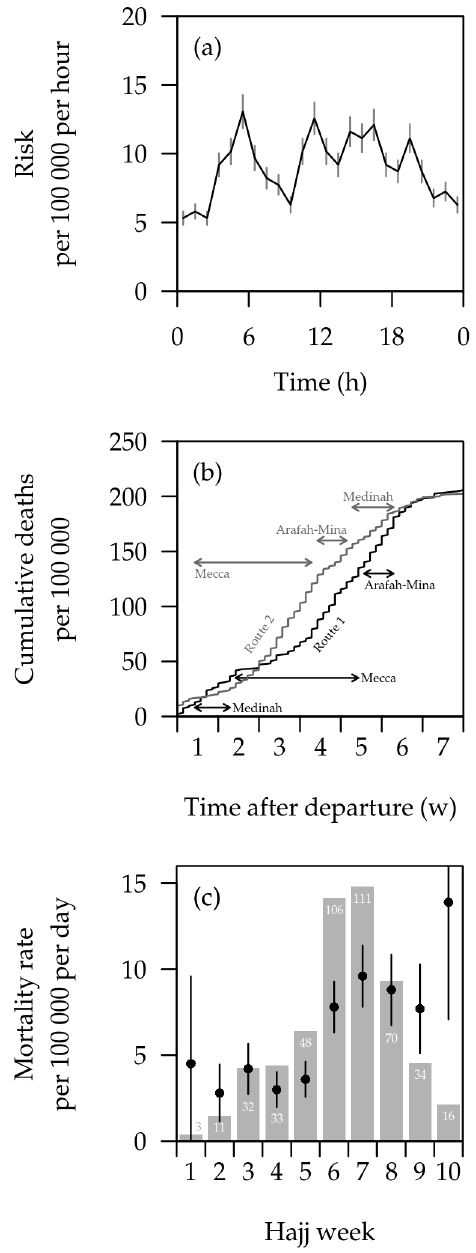
Figure 2. Timing of deaths on the Hajj. (a) Hour of death, as risk per 100,000 pilgrim-hours, with 95% confidence intervals. (b) Cumulative number of deaths over course of the Hajj, for two routes, per 100,000 pilgrimages. 93,357 pilgrims took route 1, and 113,474 route 2. Both routes start and end in Jeddah. (c) Mortality rate over the duration of the Hajj. Numbers of deaths are presented in grey bars; rate per 100,000 pilgrim-days and 95% confidence intervals are presented in black. doi: